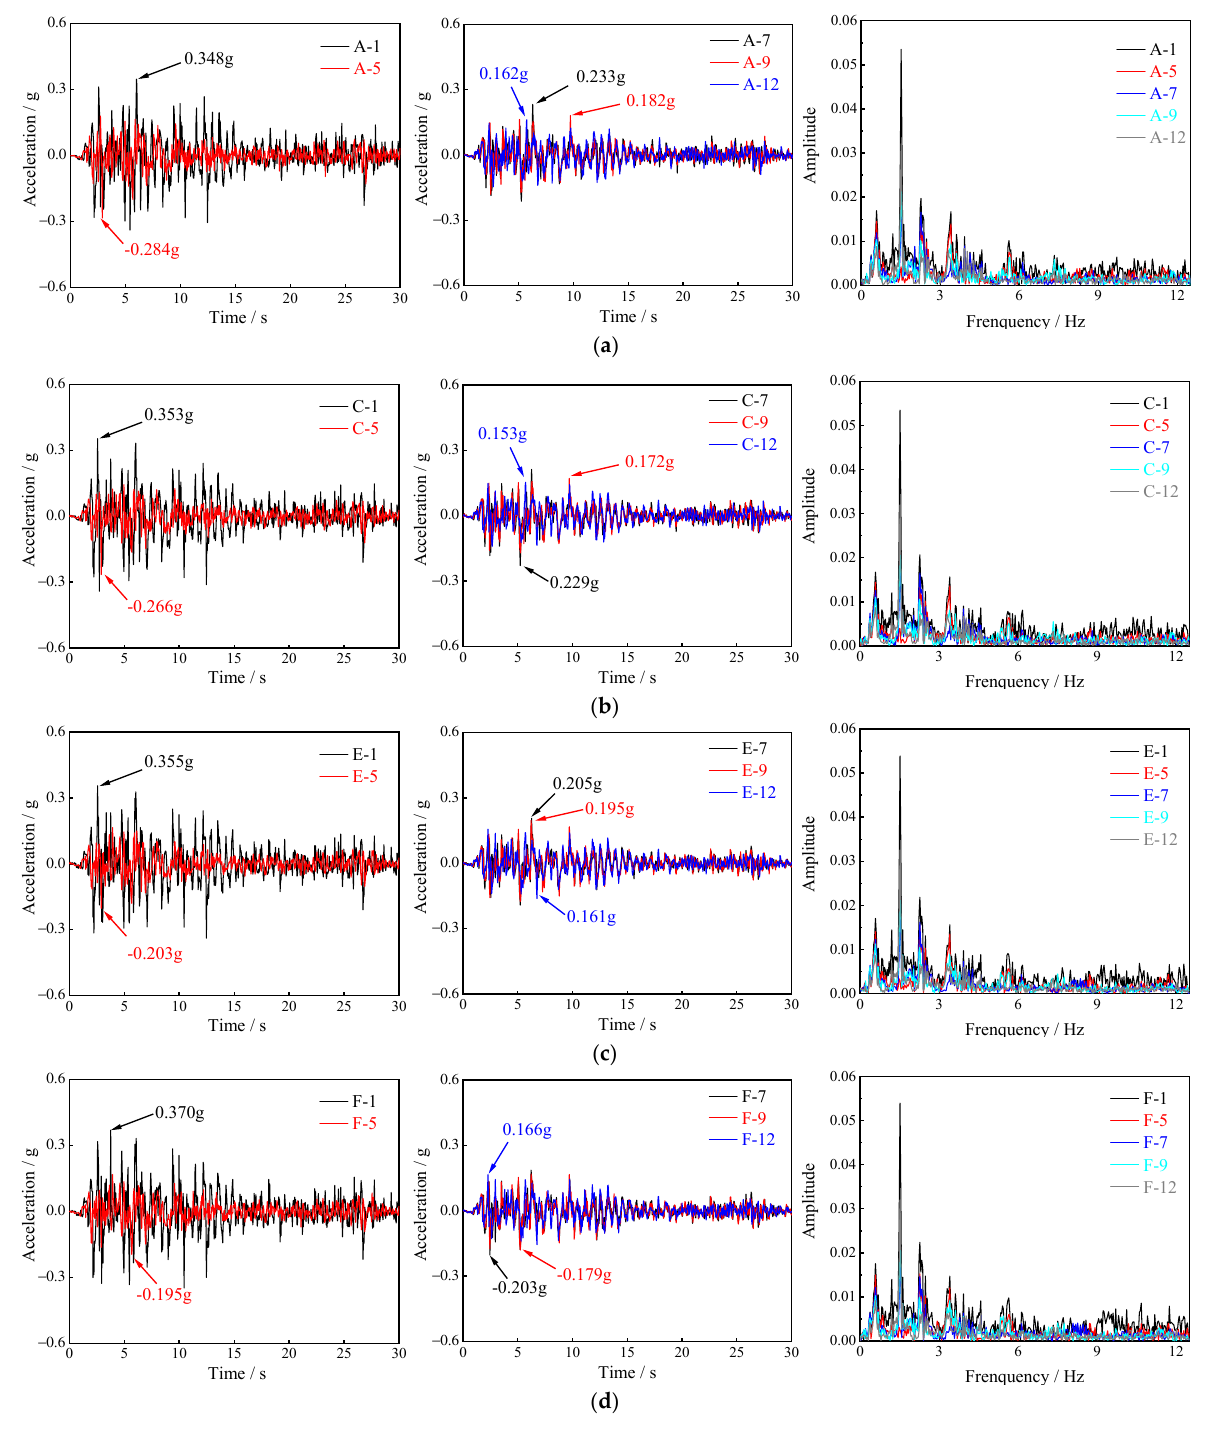
Figure 10. Time history and Fourier amplitude spectrum of acceleration- x at partial monitoring points: ( a ) monitoring point A, ( b ) monitoring point C, ( c ) monitoring point E and ( d ) monitoring point F.